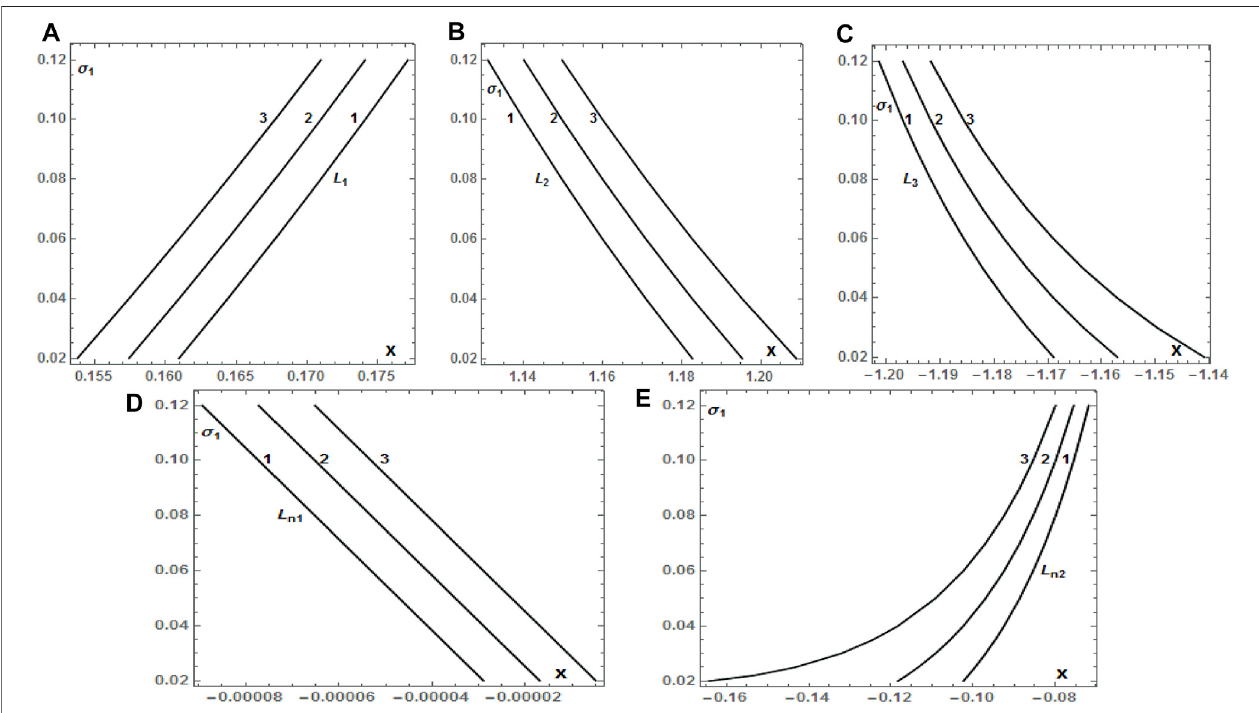
FIGURE 11 | (A – E) Positions of the collinear equilibrium points L i , i = 1, 2, 3, L nj , j = 1, 2, of the HD155876 system, as a function of σ 1 , which varies in the interval (0.02, 0.12) for fi xed values of σ 2 equal to 0.01 (1), 0.05 (2), and 0.09 (3), respectively. The radiation pressure, oblateness, mass of the disc, and triaxiality parameters of the smaller primary are kept as constants as in the previous case ( Table 8 ). The numbering of equilibrium points is according to the diagram shown in Figure 2 .